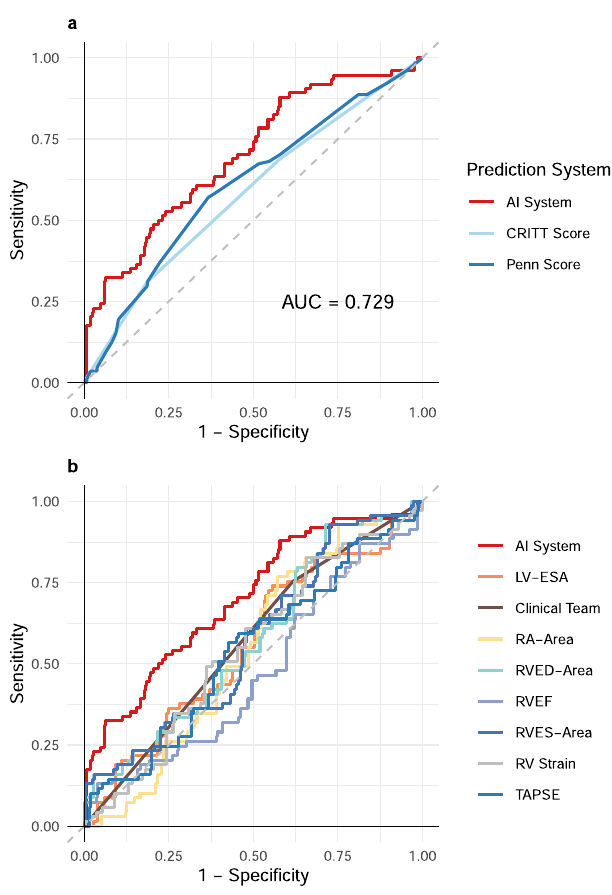
Fig. 2 Performance of the AI system, clinical risk scores, and clinical benchmarking. a ROC curve of the AI system compared to contemporary clinical risk scores. The performance of the AI system was 0.729 (95% CI 0.623 – 0.835). b ROC curves of clinical expert team and independently calculated metrics of right ventricular function compared to the AI system. The performance of the AI system was found to exceed both clinical experts and the traditional risk scoring systems. LV-ESA left ventricular end systolic area, RVED-Area right ventricular end diastolic area, RVEF RV Ejection Fraction, RVES-Area RV end systolic